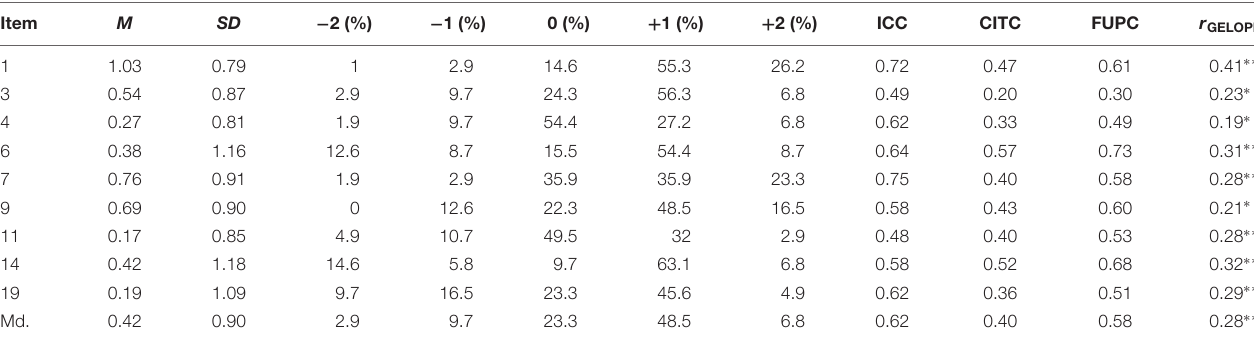
TABLE 5 | Descriptive statistics, the frequency distribution of the ratings of responses, interrater agreement, psychometric properties, and correlations with GELOPH<15> for the Picture-Geloph > (Sample 2). Item